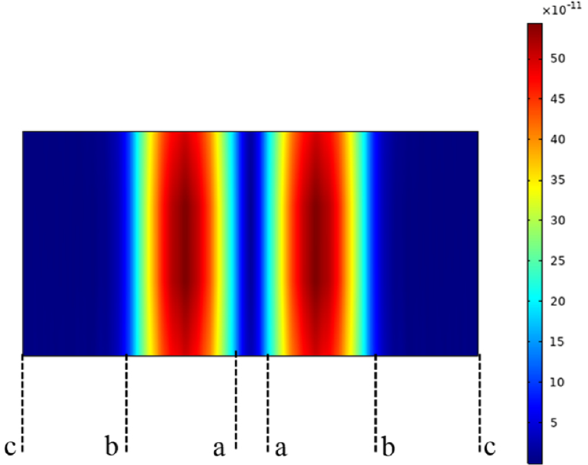
Figure 8. The vibration mode shape of the LFE resonator from COMSOL.